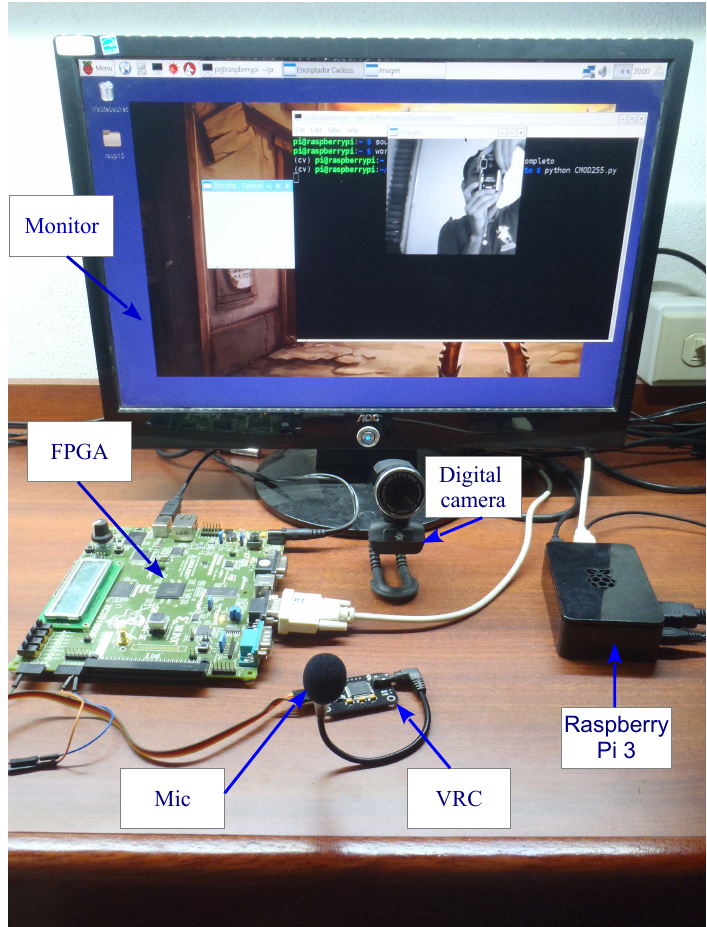
Figure 2. Experimental arrangement of the proposed embedded